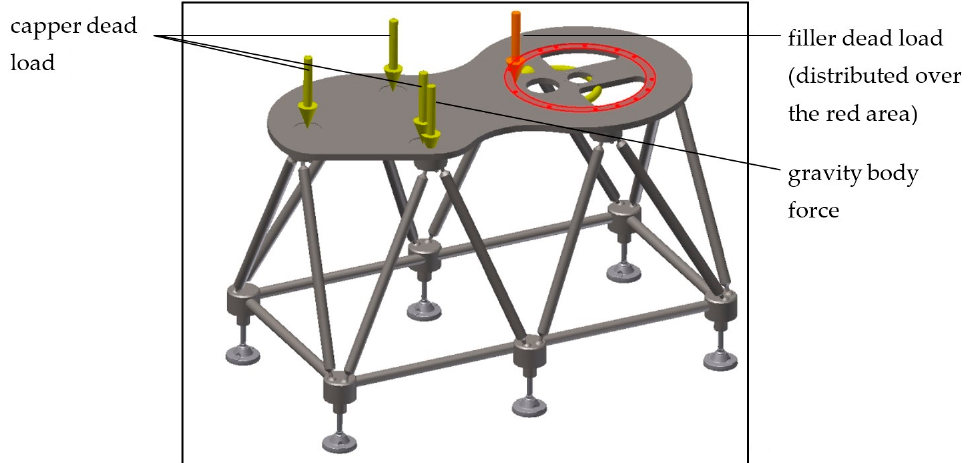
Figure 10. FLEX base model for a filler–capper combined unit.